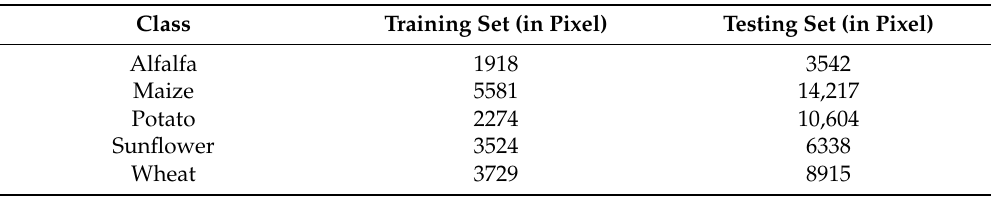
Table 2. Training and testing data set.